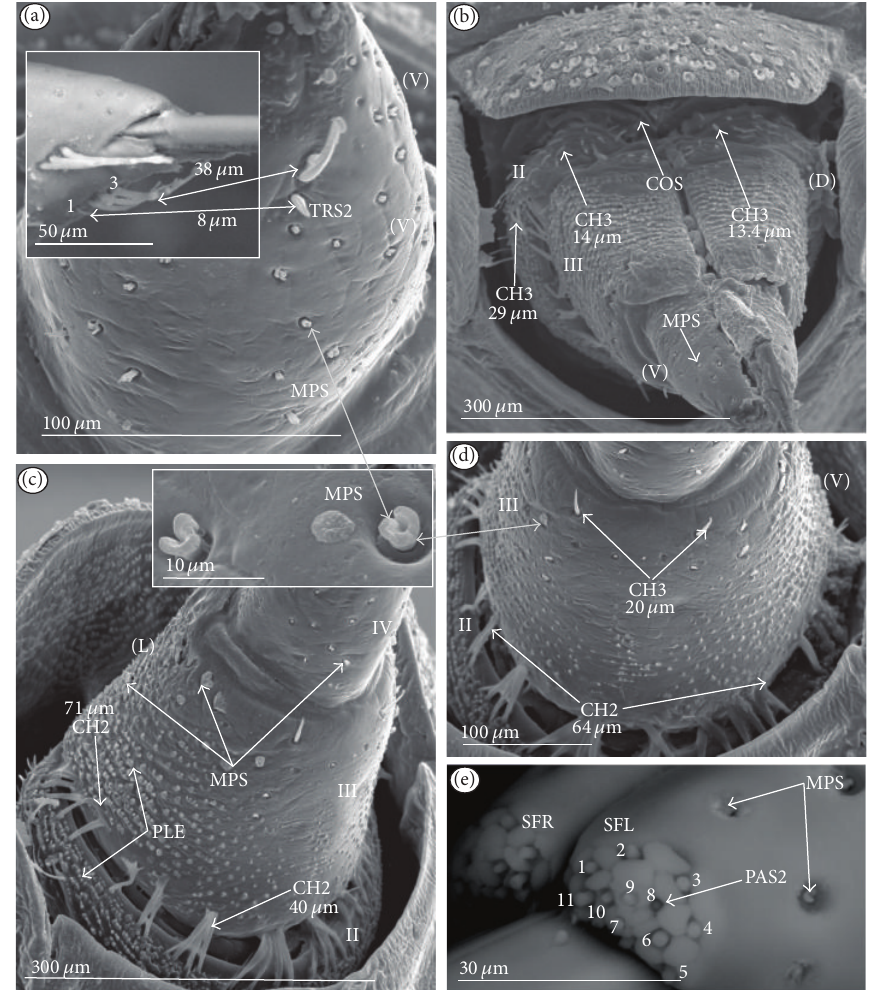
Figure 22: Types and sizes of the sensilla of the Naucoridae: Cryphocricinae ( Cryphocricos hungerfordi ). (a) MPS are numerous and spread evenly on the IV segment (ventral view); TRS2 (four) are distributed over the ventral side (V) in one row near the apex of the IV segment. (b) MPS are numerous and distributed evenly over the IV segment (dorsal view), CH3 are less numerous and situated on the dorsal surface of the II segment, and COS are situated on the II segment (dorsal view). (c) MPS are less numerous, and only a few are situated on the dorsal surface of the III segment; on this segment there are present numerous, unidentified plates (PLE); CH2 are situated around the edge of the II segment on the ventral side. (d) One pair of CH3 is situated ventrally near the distal edge of the III segment. (e) PAS2 (no. 1–11) are situated on the labial tip